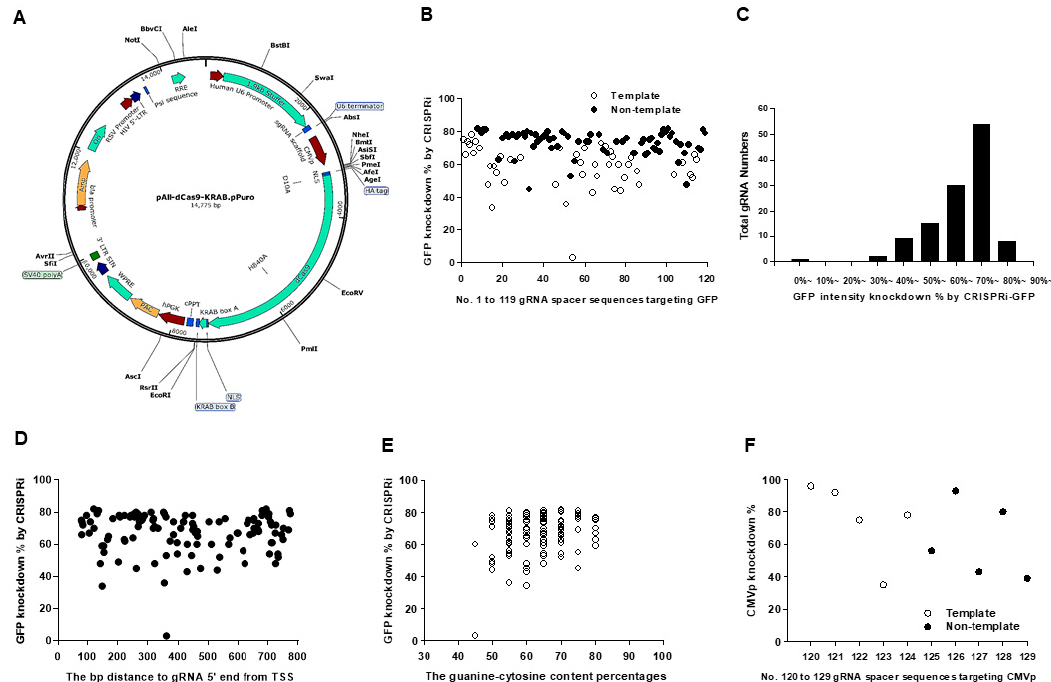
Figure 3. pAll-dCas9-KRAB.pPuro and GFP silencing efficacy in CRISPRi-GFP-transduced HEK-293 cells. ( A ) Map of pAll-dCas9-KRAB.pPuro with a dCas9/Krüppel-associated box (KRAB) repression domain, total 14,775 bp in length. Resistance to puromycin was conferred by the PAC gene. ( B ) GFP knockdown percentages in CRISPRi-GFP-transduced HEK-293 cells in 119 gRNA spacer sequences targeting the d2EGFP coding region. ( C ) Spike graph showing the numbers of designed gRNAs in variable GFP knockdown zones. ( D ) GFP knockdown efficacy by 119 gRNA spacer sequences with different targeting distance from TSS. ( E ) GFP knockdown efficacy and the guanine-cytosine content percentages of 119 gRNA spacer sequences. ( F ) CMVp knockdown percentages in p5w-dCas9-KRAB.pBsd- and pU6-sgRNA.Ppuro-transduced HEK-293 cells in 10 gRNA spacer sequences targeting the CMVp region. The results in ( B – E ) are representative of at least two independent experiments with similar findings. HA: HA tag, human influenza hemagglutinin amino acids 98–106. NLS: nuclear localization sequence. TTS: transcription start site.